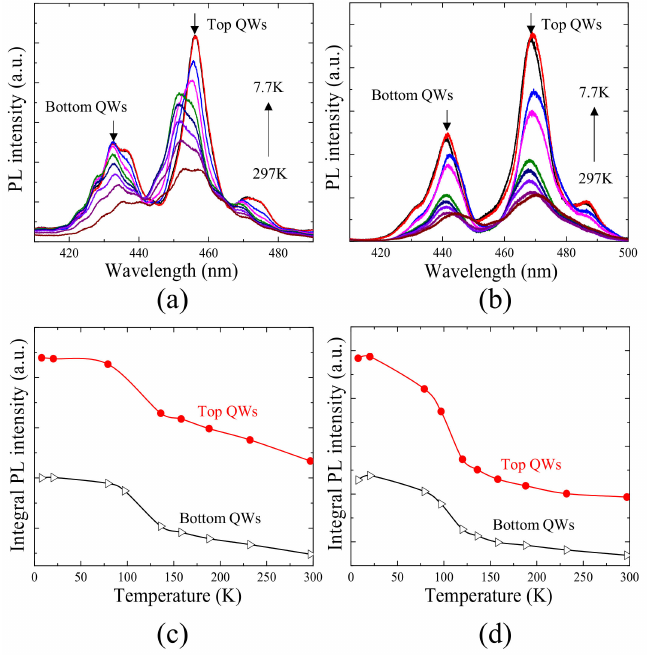
Figure 8. Temperature-dependent PL spectra for ( a ) reference sample and ( b ) sample with large V-defects. Integrated PL intensity vs. temperature for ( c ) reference sample and ( d ) sample with large